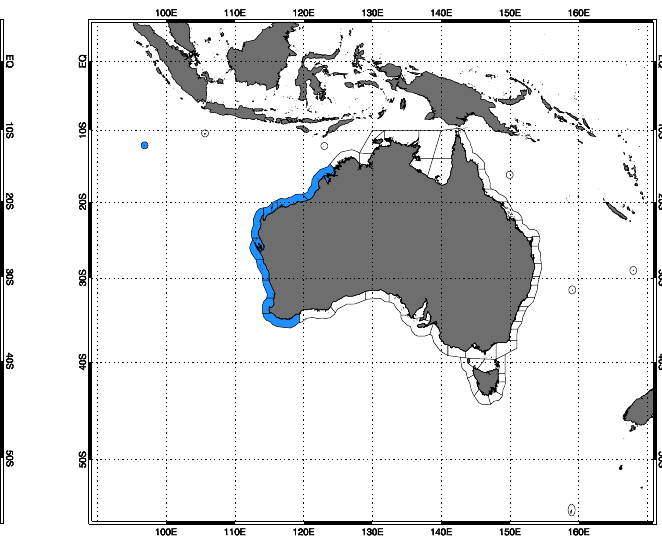
Fig. 10. Derived T2 warnings for the Sumatra 2004 event based on the thresholds in Sect. 3.2. Coastal zones assigned a marine threat are shaded in